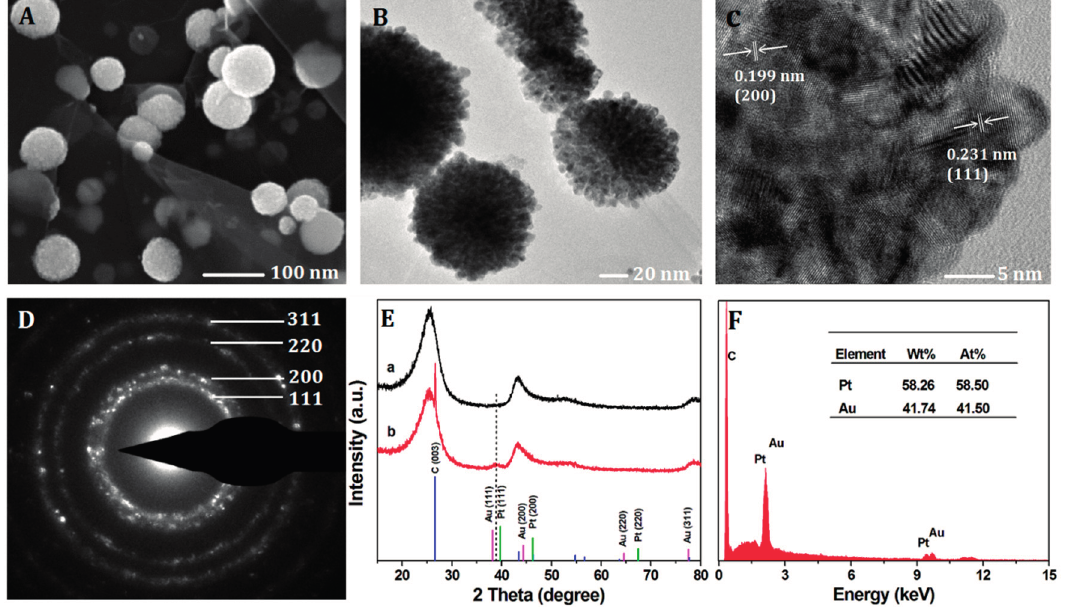
Figure 1. ( A ) FESEM image; ( B ) TEM image; ( C ) HRTEM image and ( D ) the corresponding SAED pattern of the Pt-Au/rGSs; ( E ) XRD patterns of (a) blank glassy carbon slice and (b) Pt-Au/rGSs modified on the glassy carbon slice; ( F ) EDS spectrum of the